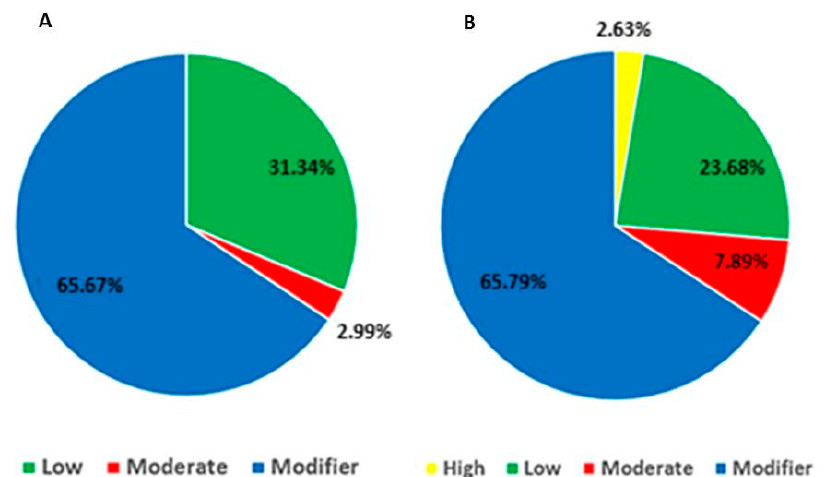
Figure 6. Impact caused by variants and its frequency. Legend: ( A ) samples from the scrotal hernia group. ( B ) Samples from the umbilical hernia group. Table 11. miRNAs identified in the transcriptomes of the pig inguinal and umbilical ring